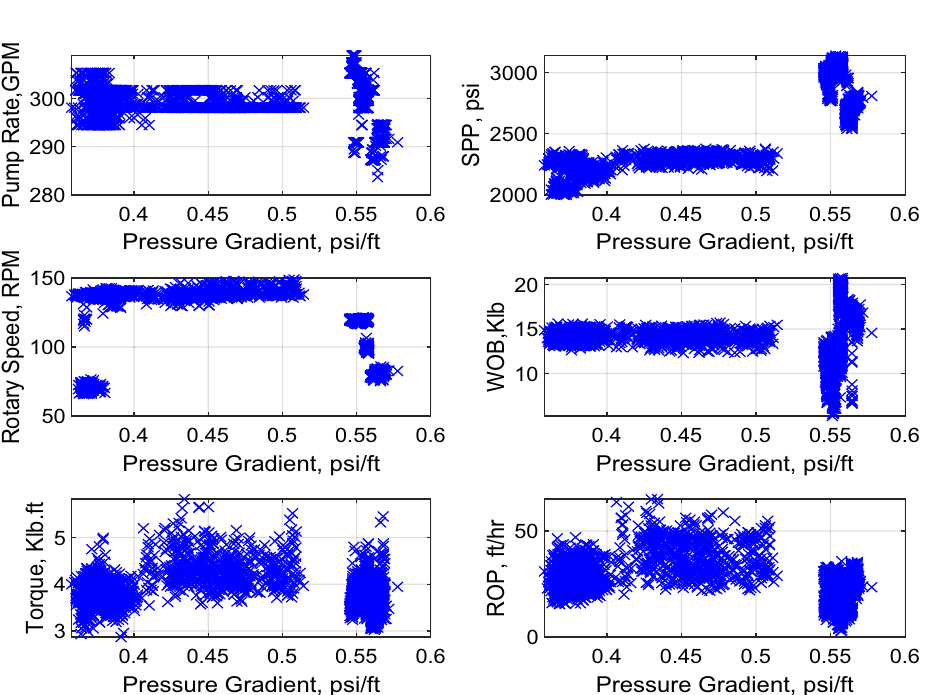
Figure 3. Cross-plots of pressure gradient versus different drilling